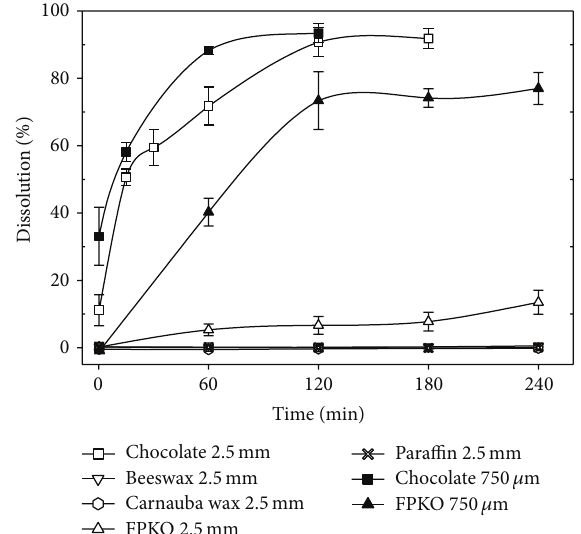
Figure 2: Effect of the matrix on dissolution of lipid-based particles in the simulated duodenum solution (DS). Results are the average of three independent assays. Error bars represent Standard Error of the Means